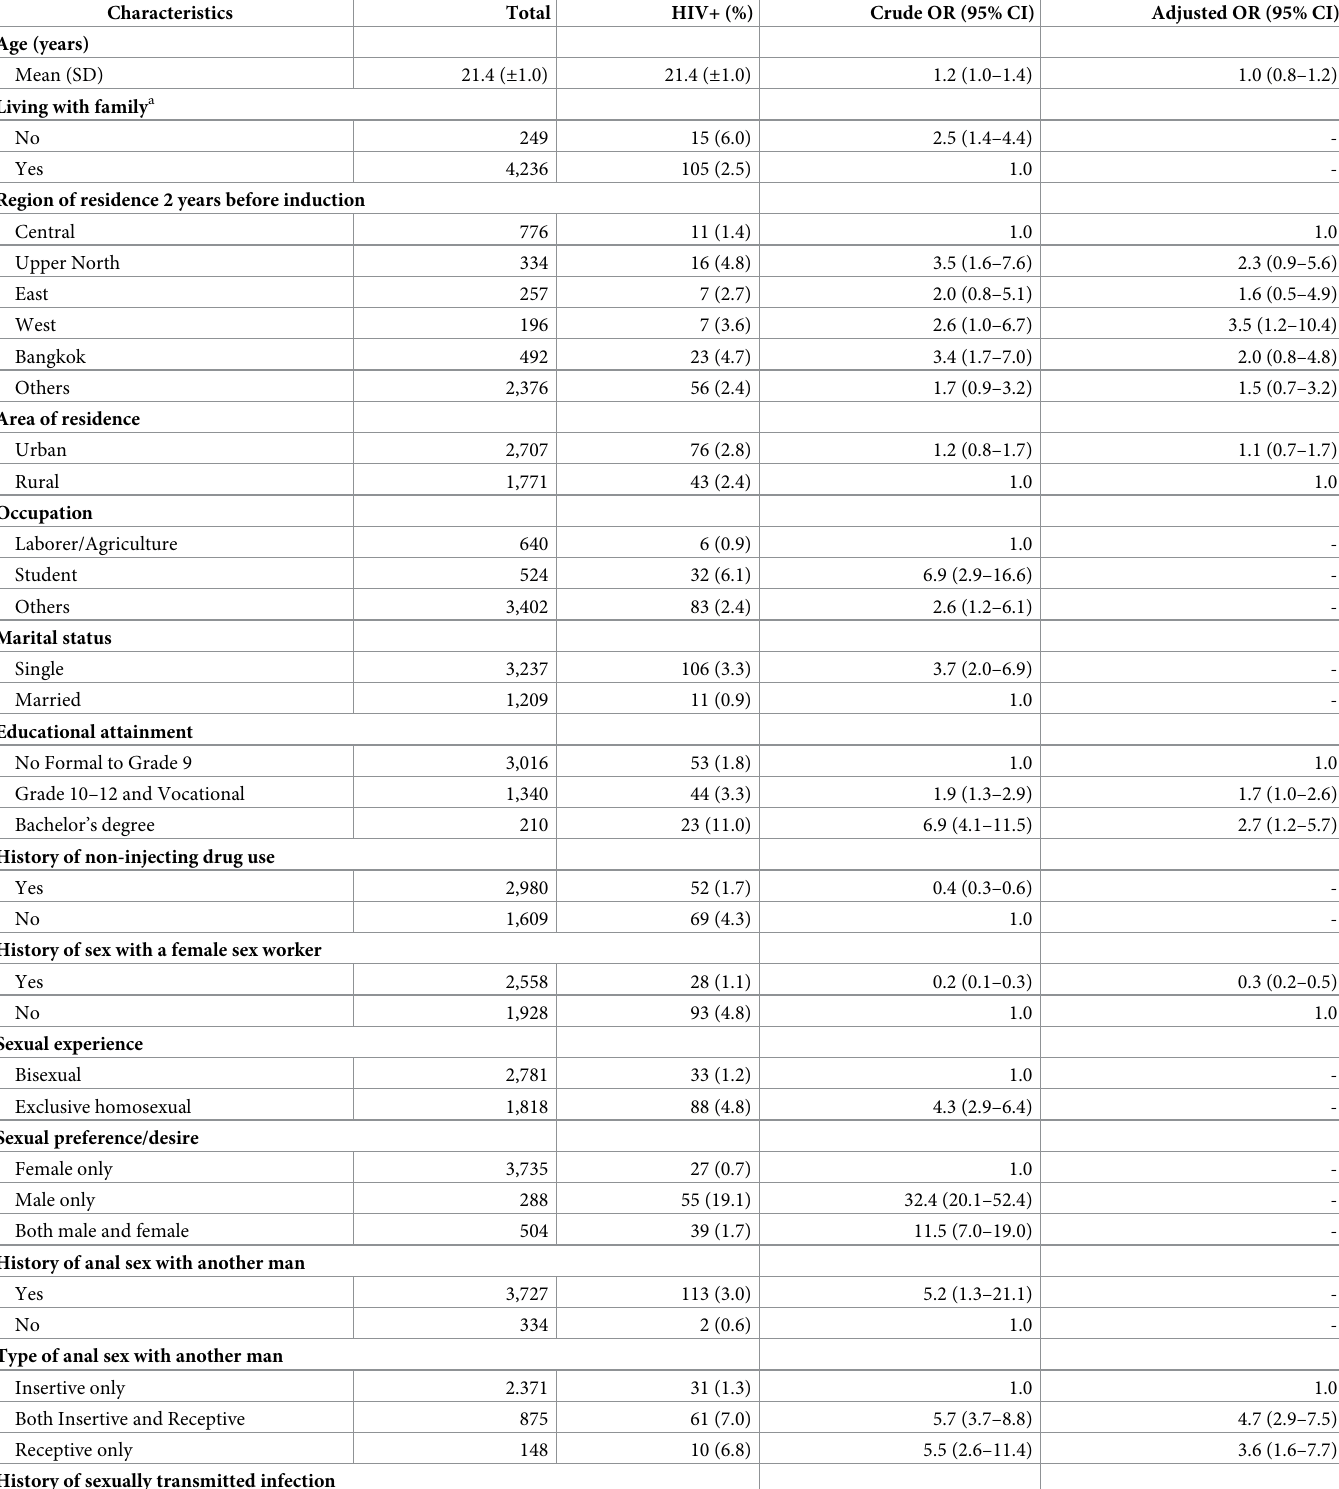
Table 4. Univariate and multivariate analysis of risk factors to HIV infection among identified MSM inducted into the RTA in November 2010 and May 2011.